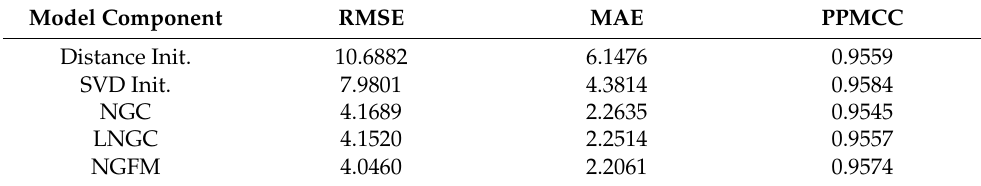
Table 3. Validation of model components.